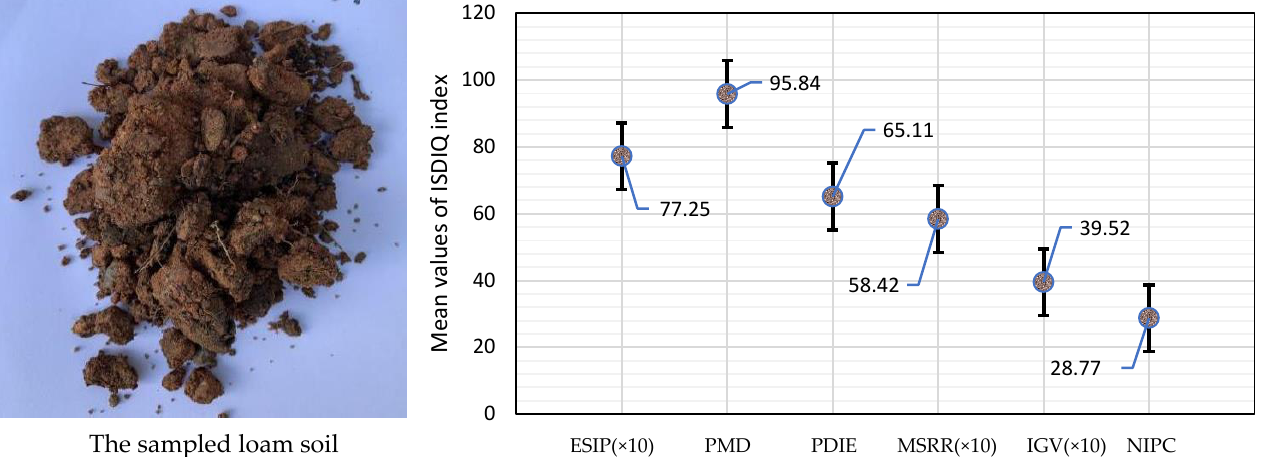
Figure 7. The loam soil specimen and its corresponding SDIQ index values obtained from the sampled layer D.